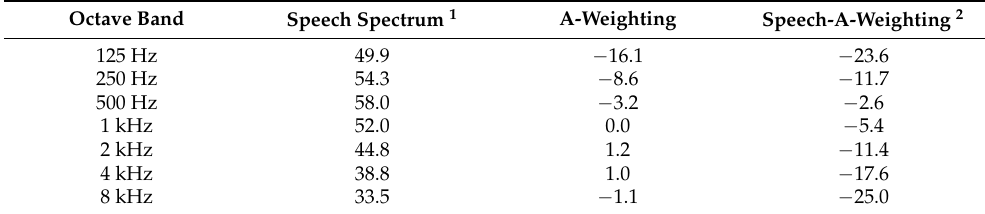
Table 1. Speech- and A-weighting values in decibels for the seven octave bands spanning 125 Hz–8 kHz. Values are in